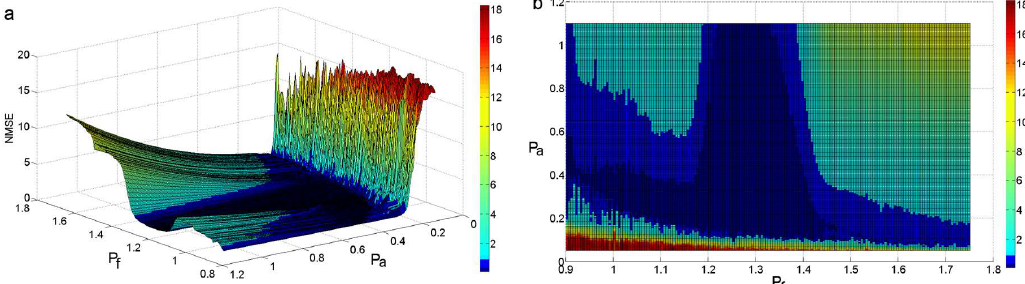
Figure 10. The distribution of the NMSE. ( a ) The three-dimensional distribution of the NMSE; ( b ) The distribution plan of the NMSE.